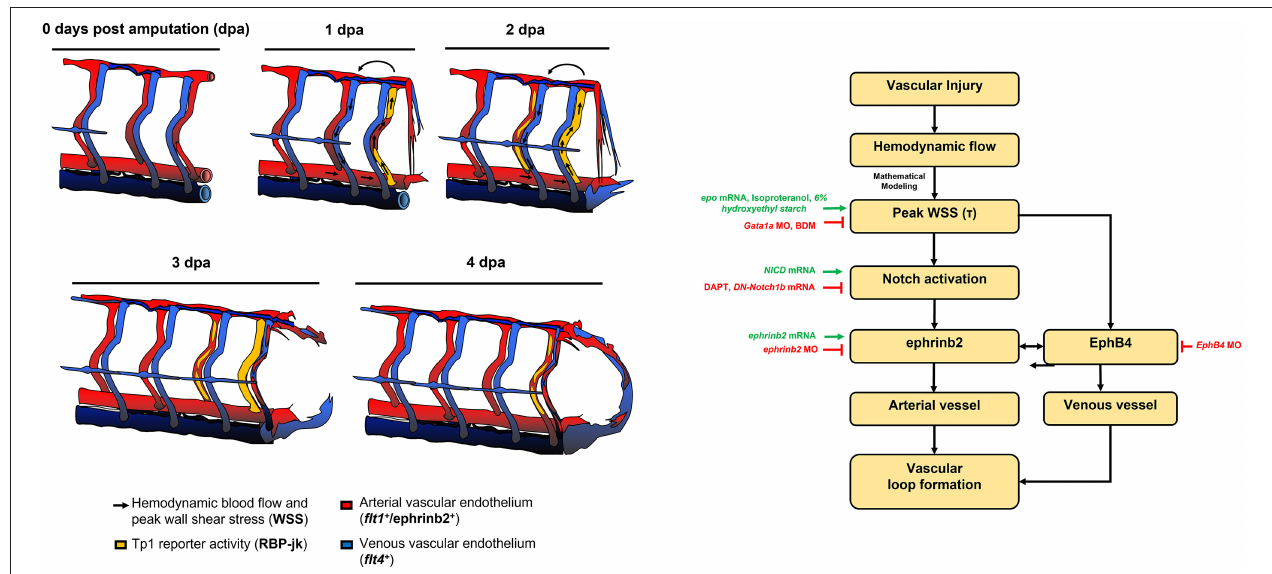
FIGURE 7 | Schematic overviews of the proposed mechanisms underlying WSS-activated regrowth of the vascular